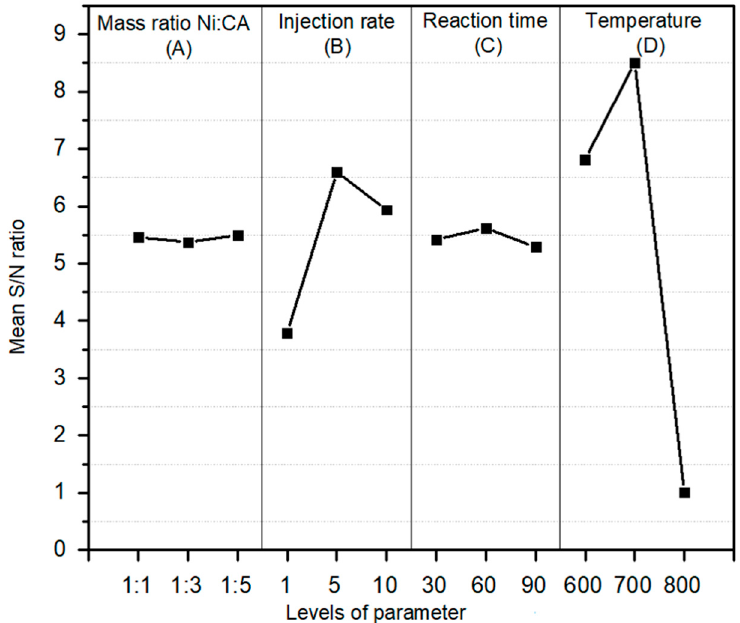
Figure 4. The mean S/N ratio of three levels at four different parameters assigned as mass ratio of Ni:CA ( A ); injection rate of carbon source ( B ); reaction time ( C ); and operating temperature ( D ).